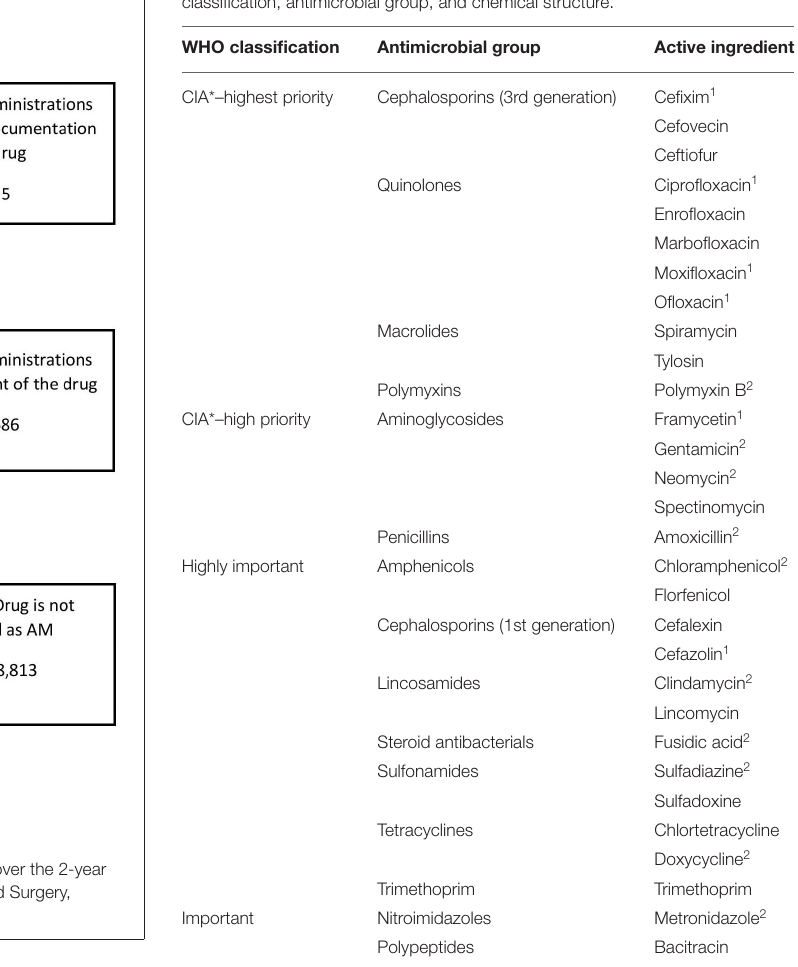
TABLE 1 | Active ingredients documented to be used in pets in 2017 and 2018 at the Department of Small Animal Medicine and Surgery, University of Veterinary Medicine Hannover, according to the World Health Organization (WHO) classification, antimicrobial group, and chemical